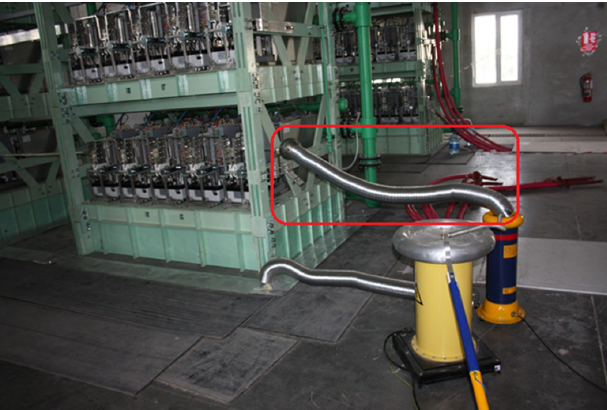
Figure 9. Aluminum flexible pipe for test cable shielding.